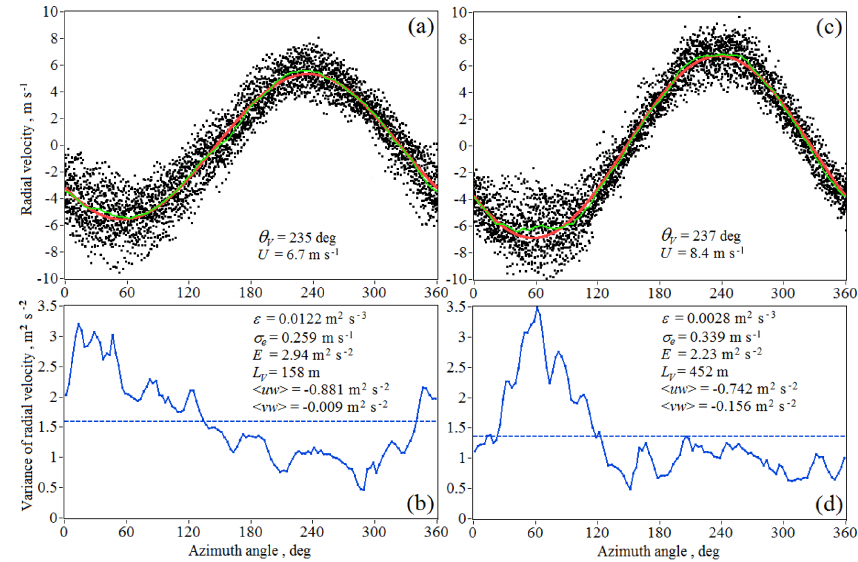
Figure 6. Single estimates of the radial velocity V L (θ m , R k , n) (dots); radial velocity averaged over 30 scans, < V L (θ m , R k ) > (green curves); radial velocities as a result of sine-wave fitting, V L (θ m , R k ) = S (θ m ) · < V (h k ) > (red curves) (a, c) and variances of the lidar estimate of (θ m , h k ) (blue curves) (b, d) as functions of the azimuth angle θ m obtained from measurements by the Stream Line the radial velocity σ 2 L lidar on 22 July 2016 from 14:09 to 14:39LT at the heights h k = R k sin ϕ E = 109m (a, b) and 504m (c, d) . Dashed lines show variances averaged over the azimuth angle σ 2 L